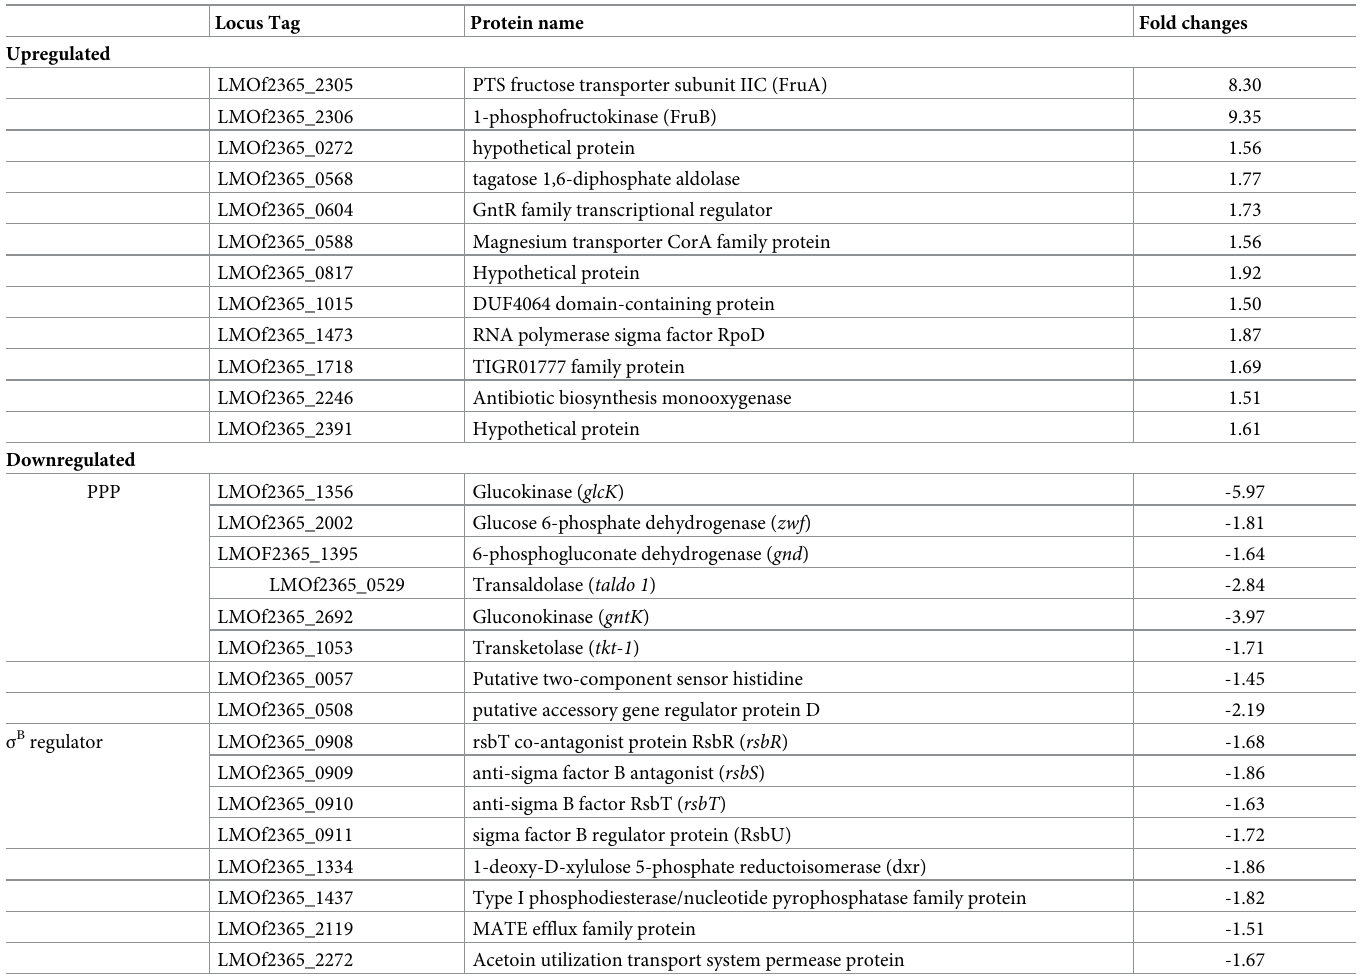
Table 2. Genes with significantly changed expression in Δ fruR strain. Locus